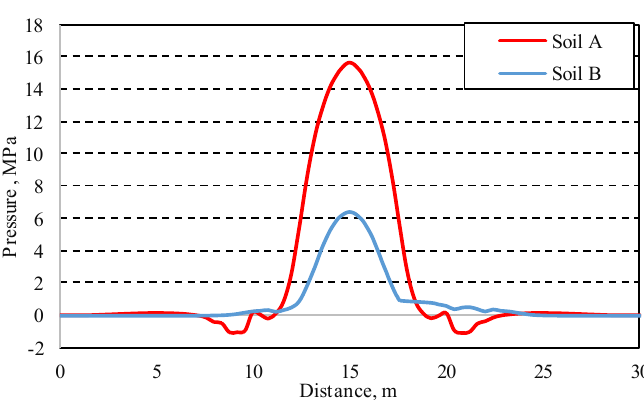
Figure 12: Maximum pressure with distance for soil (A) and (B) along path (2).